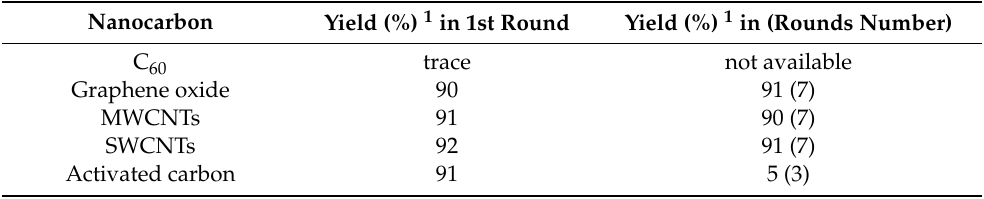
Table 1. Catalytic activity and stability of L-proline / nanocarbons in Aldol